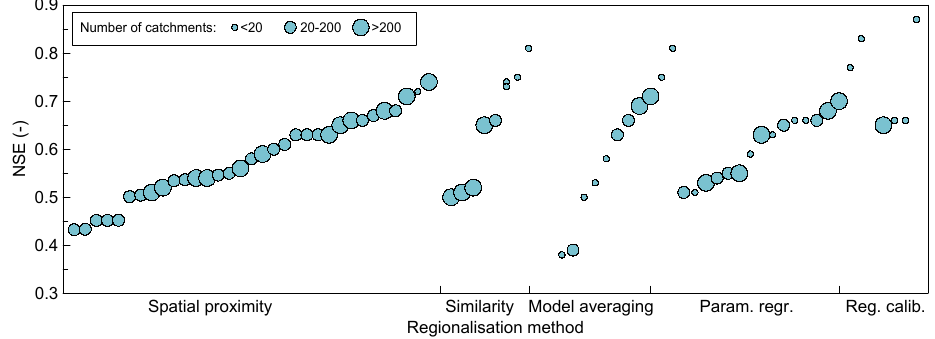
Fig. 5. Median Nash–Sutcliffe efficiency of predicting hydrographs in ungauged basins stratified by the regionalisation method and ranked by performance (Level 1 assessment). Each symbol refers to a result from the studies in Table 1. Circle size indicates number of catchments per study.